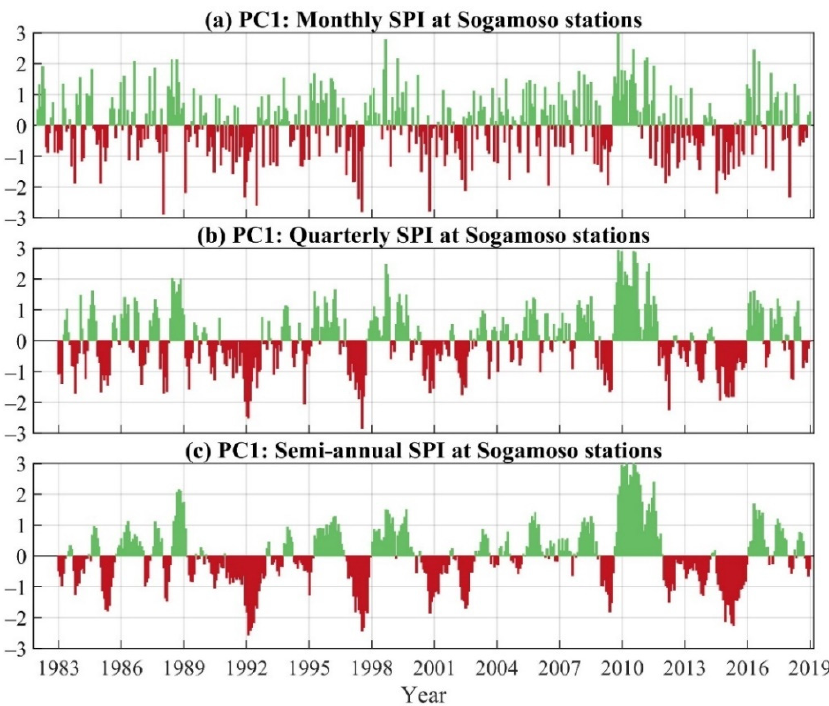
Figure 3. The 1982–2019 time series of the principal components for ( a ) monthly SPI, ( b ) quarterly SPI, and ( c ) semiannual SPI in the Sogamoso River Basin.